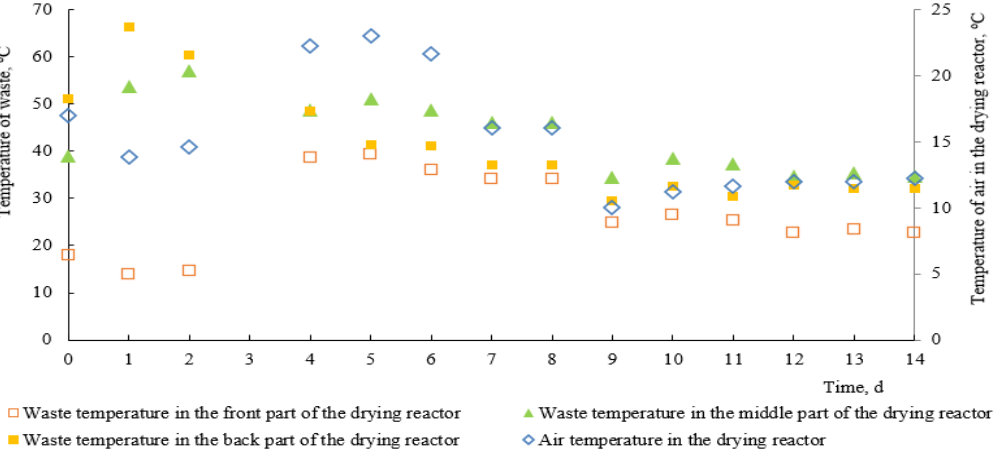
Figure 4. The temperature registered during the 14 days of the biodrying in the three parts of the reactor.